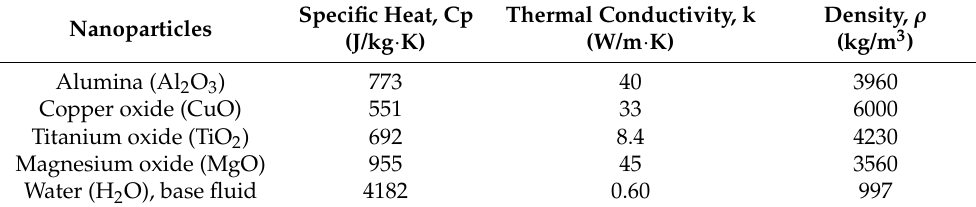
Table 2. Properties of different nanoparticle and base fluid [50–52].